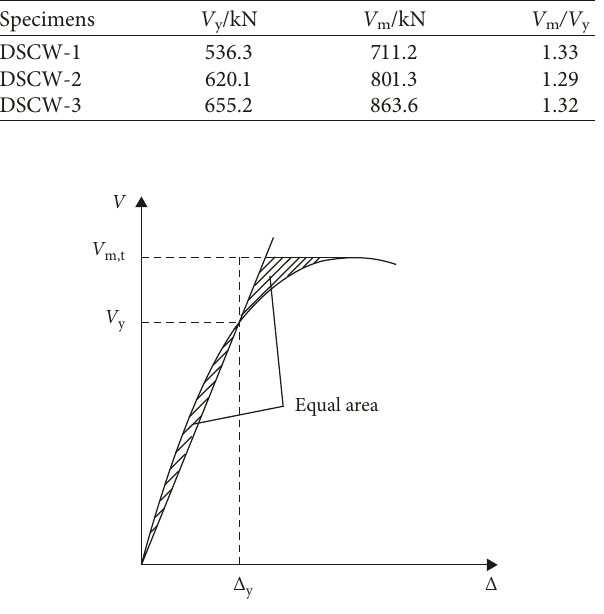
Figure 7: Determination method of yield displacement. Table 3: Lateral displacement and ductility